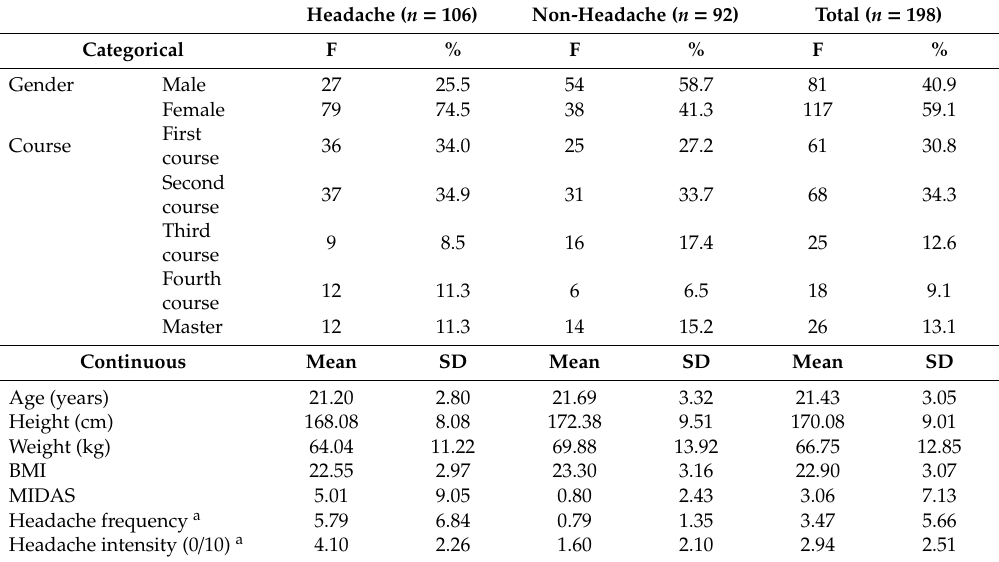
Table 1. Description of the study participants.